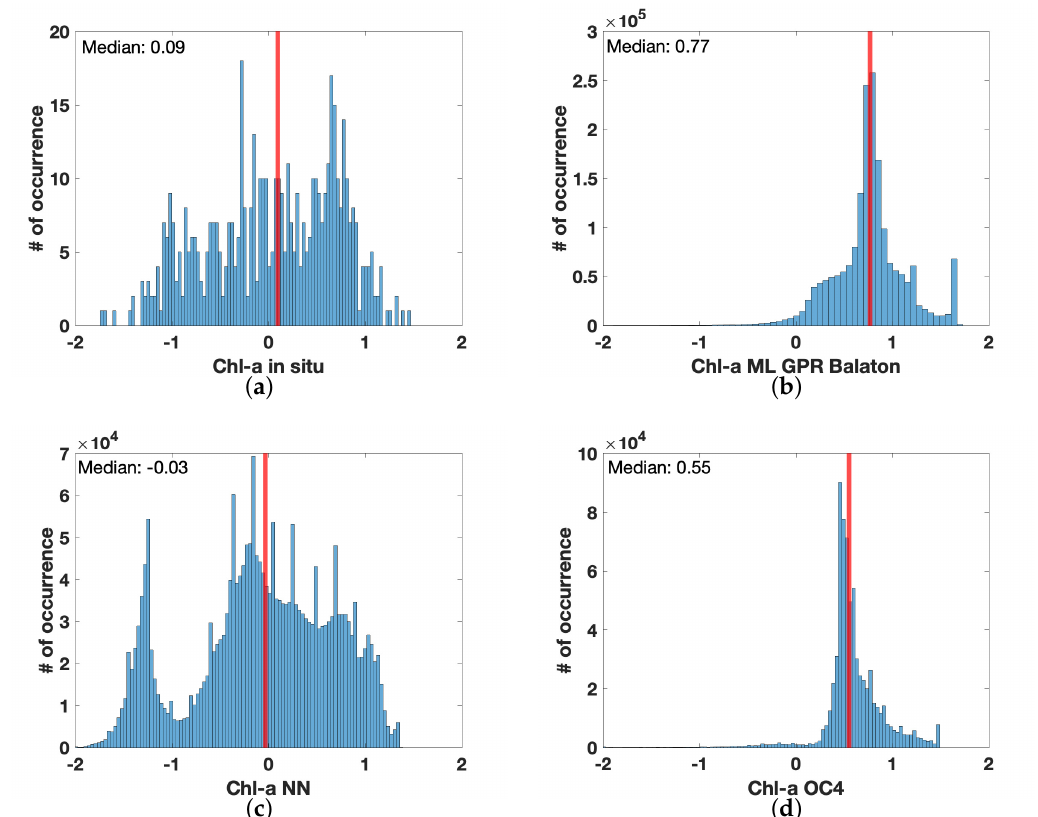
Figure 9. The histograms of the log transformed in situ Chl-a used for training the ML GPR Balaton model ( a ), estimated Chl-a by using the ML GPR Balaton model ( b ), NN complex water estimates ( c ) and OC4 open water estimates ( d ). The red lines indicate the median of the